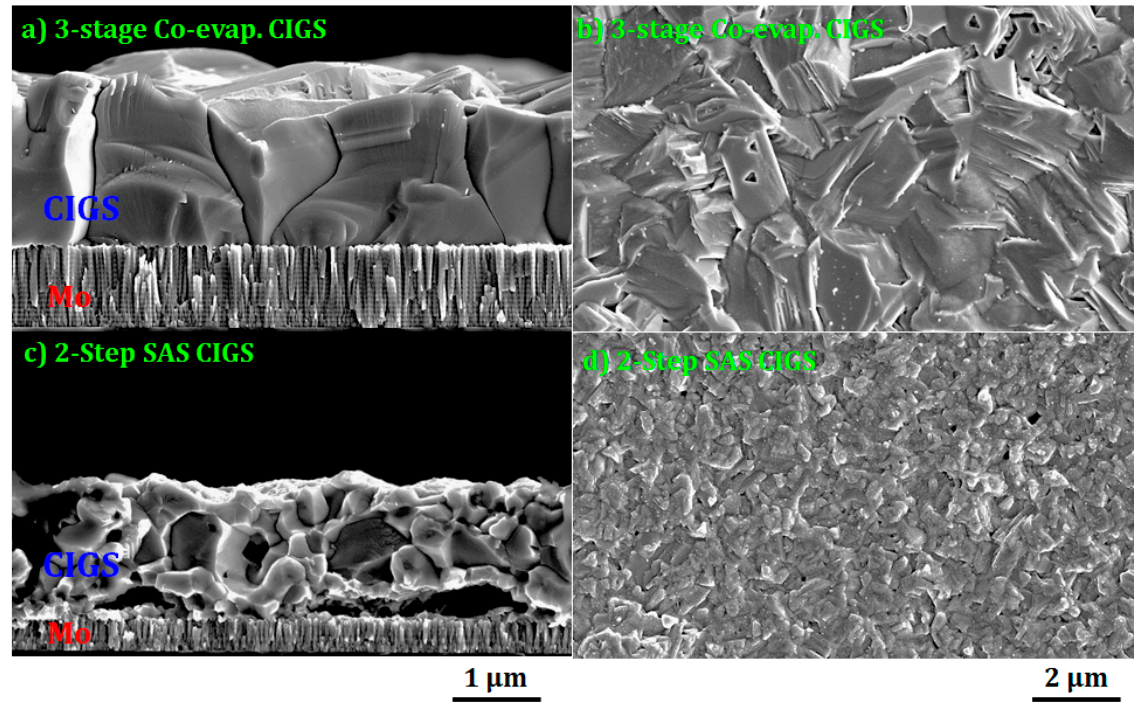
Figure 2. Surface and cross-sectional SEM images of the ( a , b ) three-stage co-evaporated CIGS and ( c , d ) two-step SAS